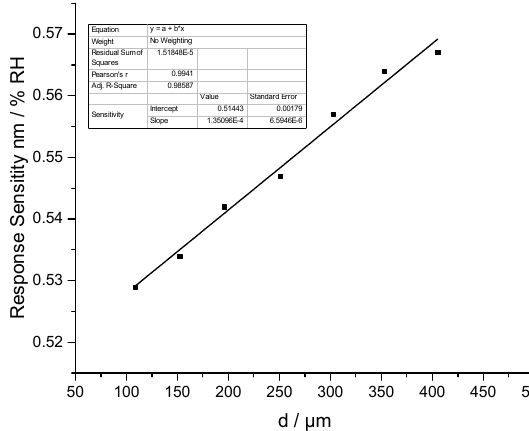
Figure 8. The humidity response sensitivity with a different Fabry-Perot cavity length.